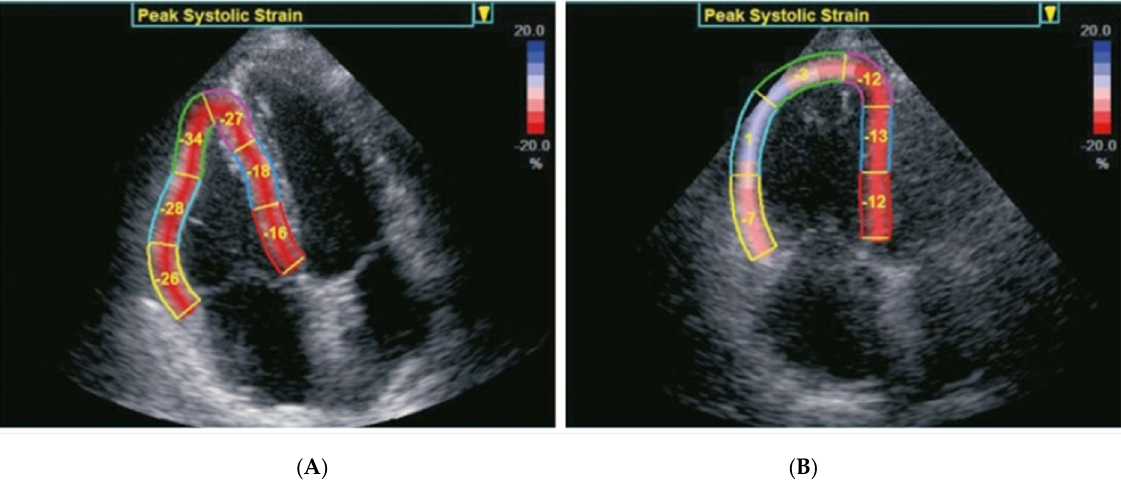
Figure 1. Examples of right ventricular strain analysis by speckle-tracking echocardiography. ( A ) Patient with a normal RV function. ( B ) Patient with a reduced RV function.